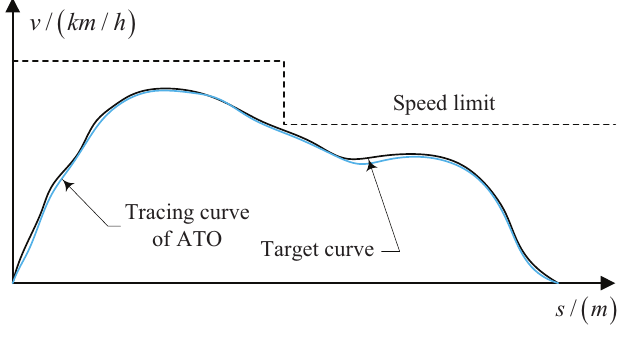
Figure 2. Speed tracking of ATO